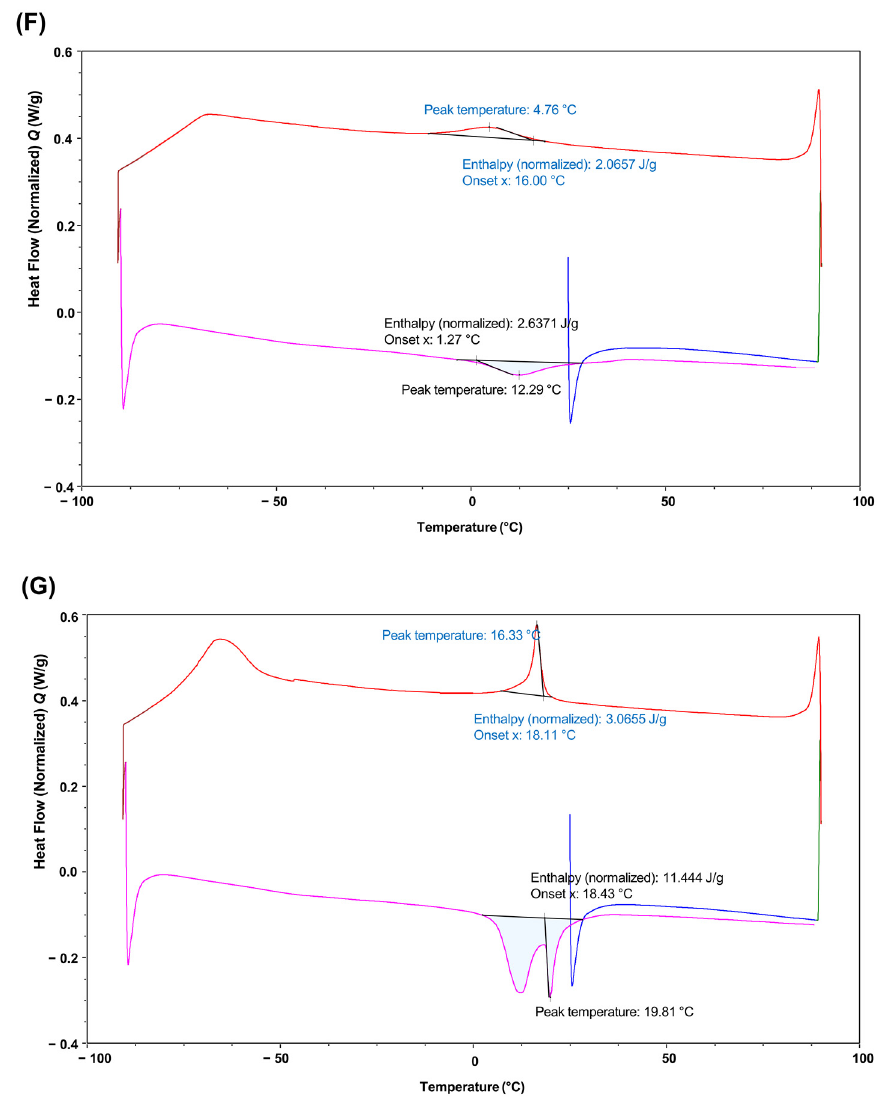
Figure 6. DSC curves of ( A ) ProFile, ( B ) ProTaper Gold, ( C ) ProfaTaper Gold, ( D ) HyFlex CM, ( E ) V Taper 2H, ( F ) 2Shape, and ( G ) K3XF. The upper and lower curves represent the cooling and heating curves, respectively. Table 3. Phase transformation temperatures and associated enthalpy changes derived from the DSC curves .